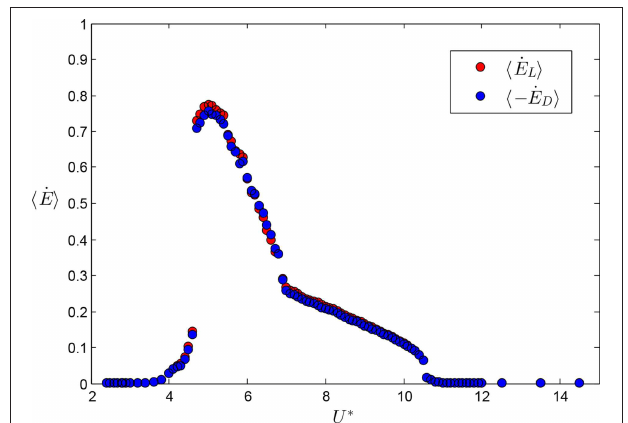
FIGURE 9 | Variation of the average rate of work done by the drag and lift components of the hydrodynamic force, h−˙ E D reduced velocity, U ∗